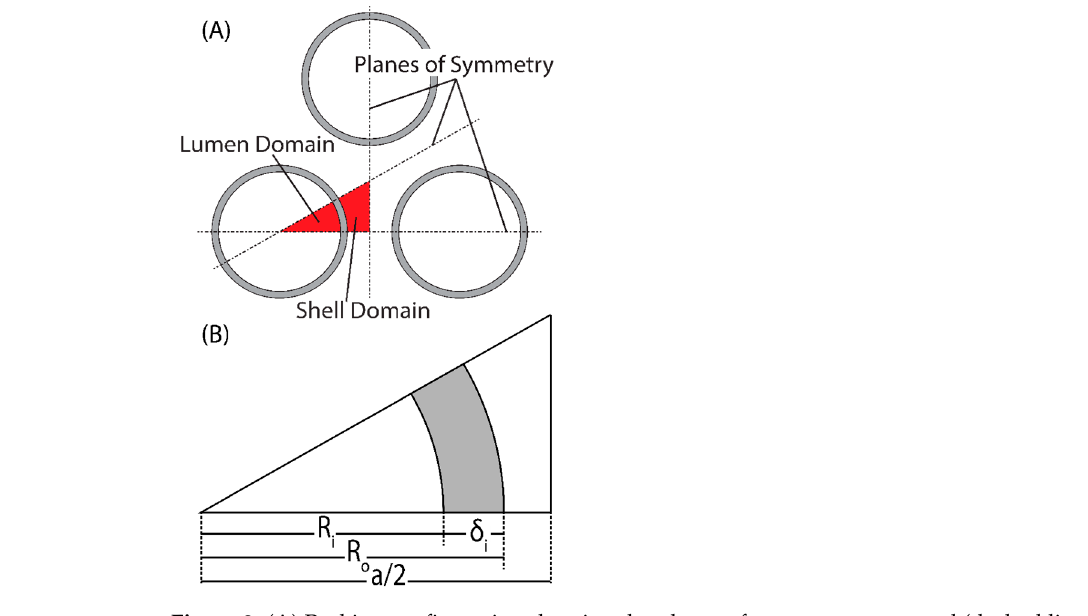
Figure 2. ( A ) Packing configuration showing the planes of symmetry generated (dashed lines), and the resulting lumen and shell domains used for computation. ( B ) Definition of variables for the computational domain in this work. Here, the gray-shaded areas represent porous membrane.